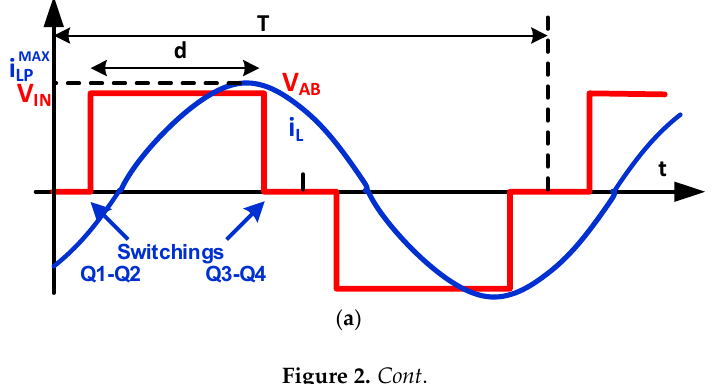
Figure 1. Series–parallel resonant topology, PRC-LCC, with a capacitor as output filter.